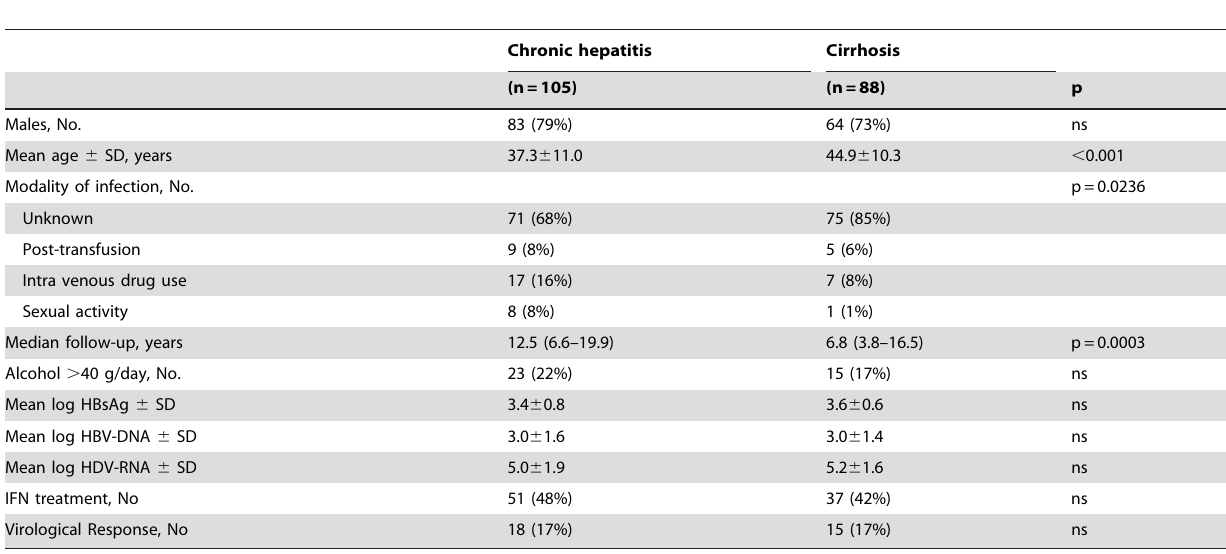
Table 2. Main baseline epidemiological and virological characteristics of the patients with and without cirrhosis.